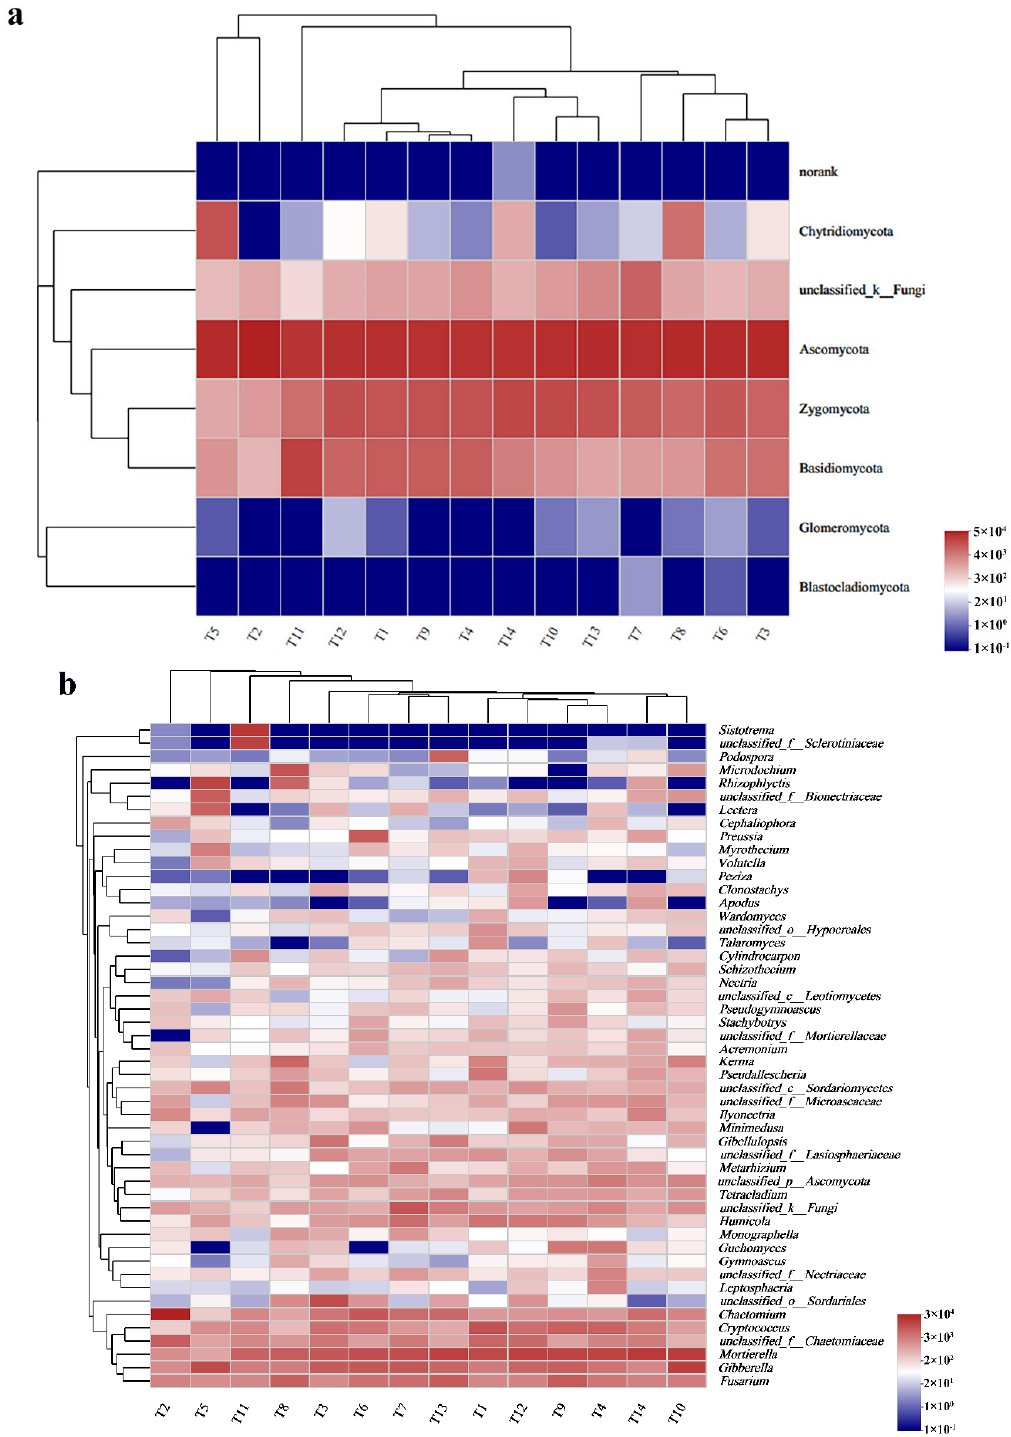
Figure 3. Differences in fungal community structures and compositions in soil samples of different aged apple orchards. ( a ) The compositions of fungal community structures characterized by the phylum level; ( b ) The compositions of fungal community structures characterized by the